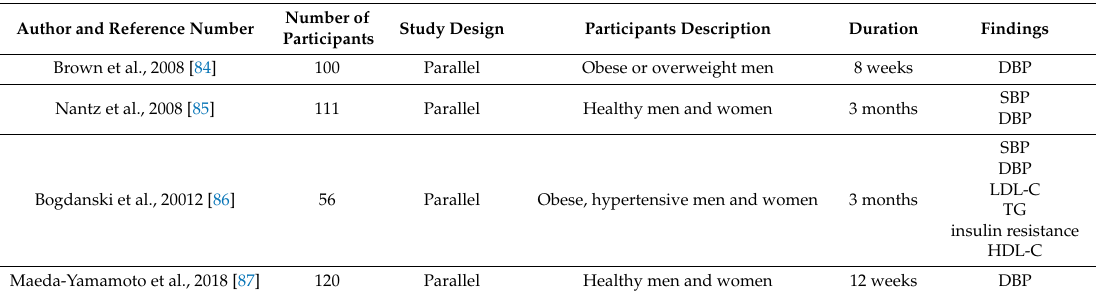
Table 7. Comparison of